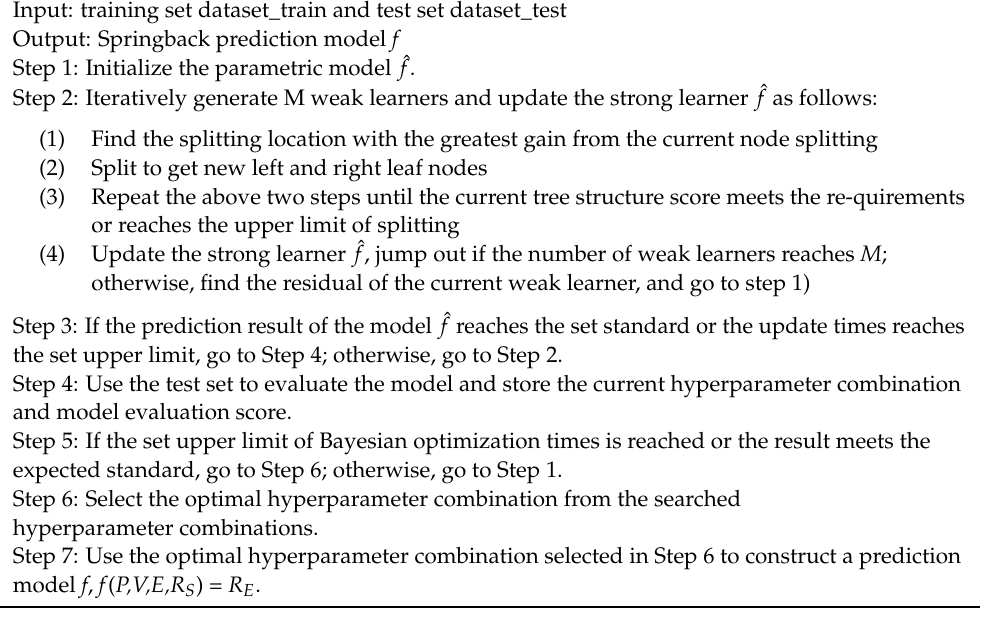
Algorithm 1: Fixed-curvature springback prediction algorithm based on XGBoost